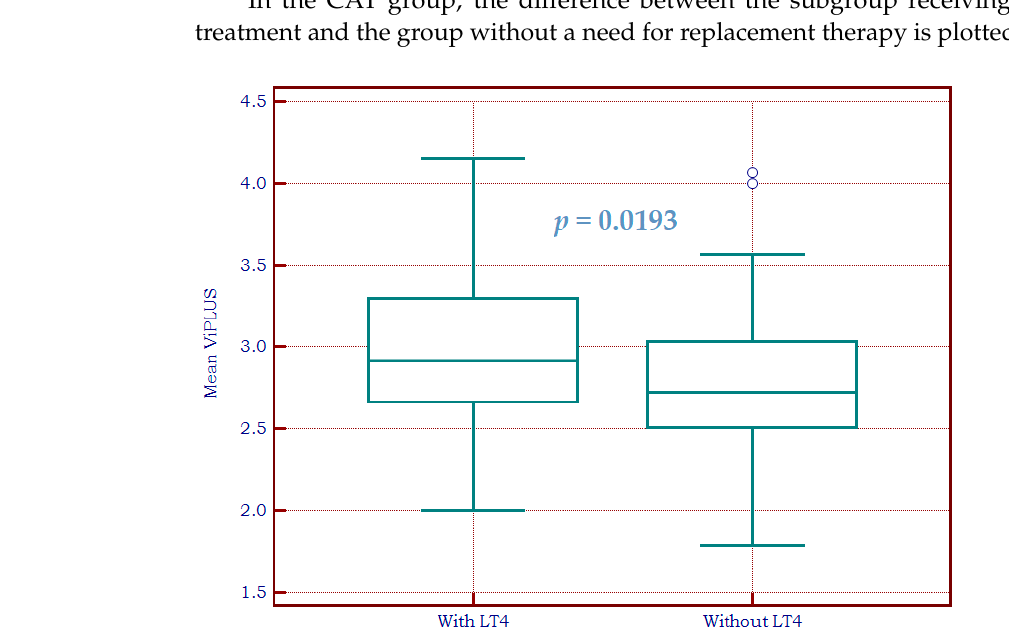
Figure 7. Box-and-whisker distribution plots representing Vi PLUS values in patients with autoim- mune thyroiditis with and without levothyroxine treatment. The AUC for detecting patients with LT4 needs in the CAT group is illustrated in Figure 8 for Vi PLUS and Figure 9 for 2D SWE PLUS. An AUC of 0.63 (0.55–0.70 CI) was obtained for the Vi PLUS measurement, and an optimal cut-off of >2.6 Pa · s (Se = 80%, Sp = 43.18%, NPV = 74.5%, PPV = 51%). For 2D SWE, an AUC of 0.59 (0.51–0.67 CI) was obtained and an optimal cut-off value of >24.5 kPa (Se = 50.77%, Sp = 68.18%, NPV = 62.5%, PPV =